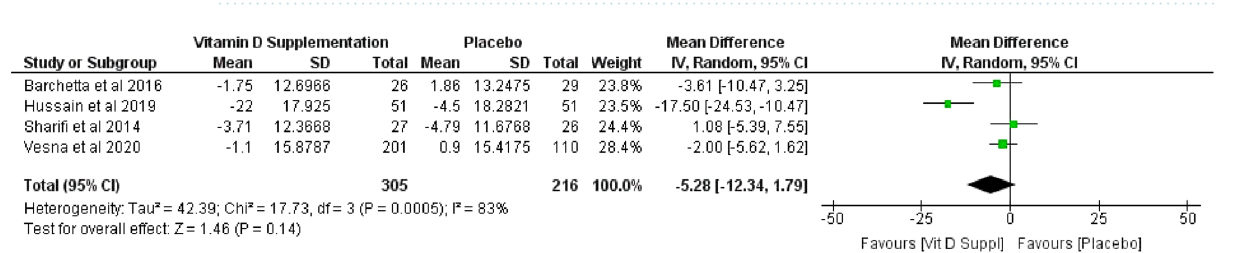
Figure 5. Forest plot of ALT levels.